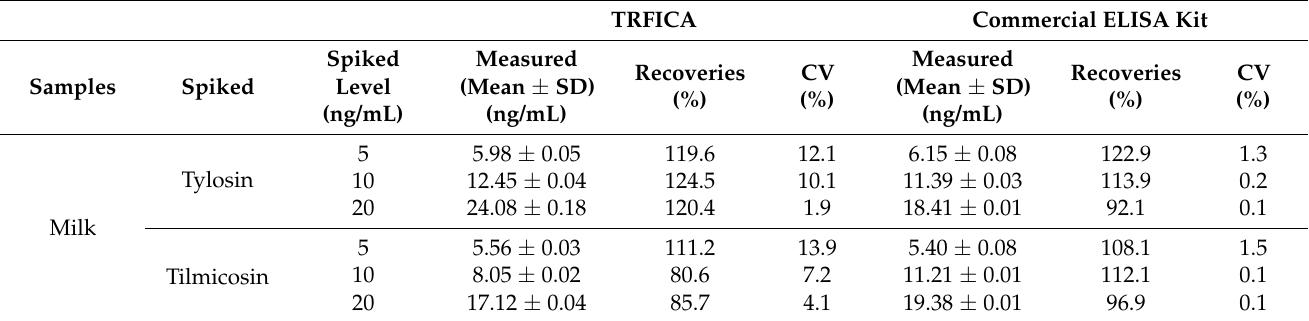
Table 4. Recoveries of tylosin-spiked and tilmicosin-spiked samples ( n = 3).